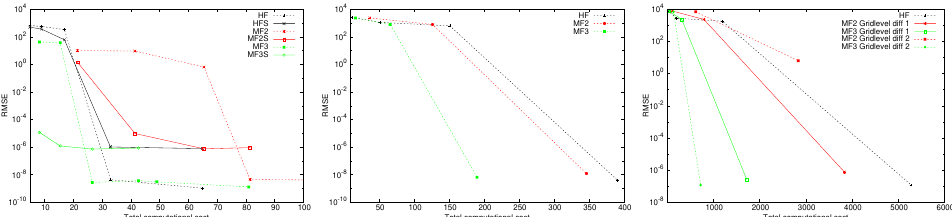
Figure 11. PCE: Rosenbrock function RMSE (from left to right, two, five and ten dimensions). PCE and SPCE in dashed and solid lines, respectively.